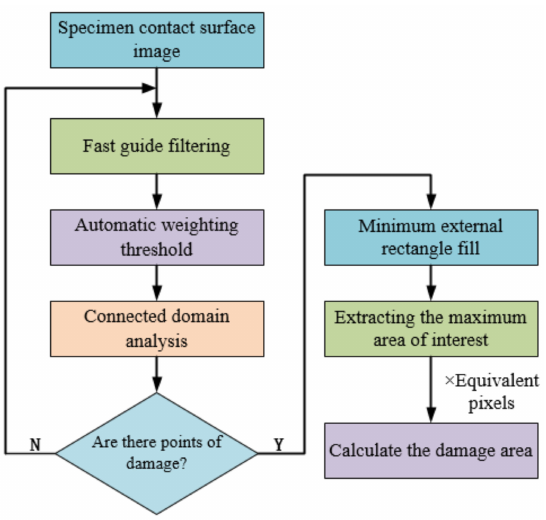
Figure 10. Calculation process of specimen damage area.